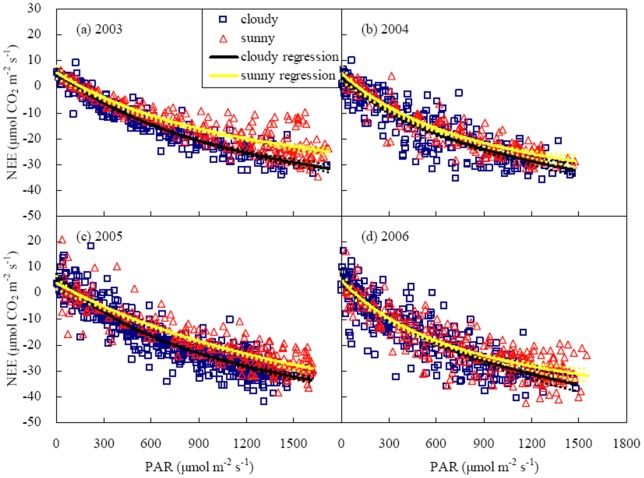
Response of NEE to PAR under sunny and cloudy sky conditions in a winter wheat field during the period of large leaf area index (0.8LAImax<LAI<LAImax).Light response curves (solid curves) were fitted using the rectangular hyperbolic function (Eq. (3)). The values of light response parameters were shown in Table 3. Between the upper and lower dotted curves were 95% confidence intervals.